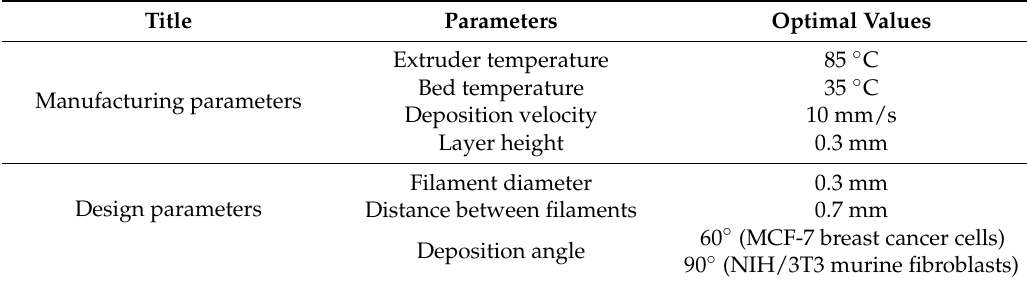
Table 3. Optimal processing parameter values to be used for PCL scaffold printing.